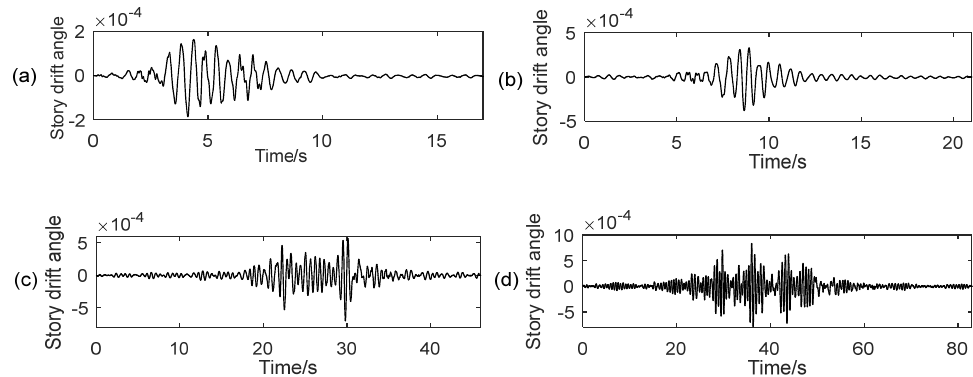
Figure 10. Story drift angle time histories of the bottom story of the frame structure under typical seismic ground motions (frequent earthquakes): ( a ) site I group 1; ( b ) site II group 2; ( c ) site III group 3; ( d ) site IV group 3.